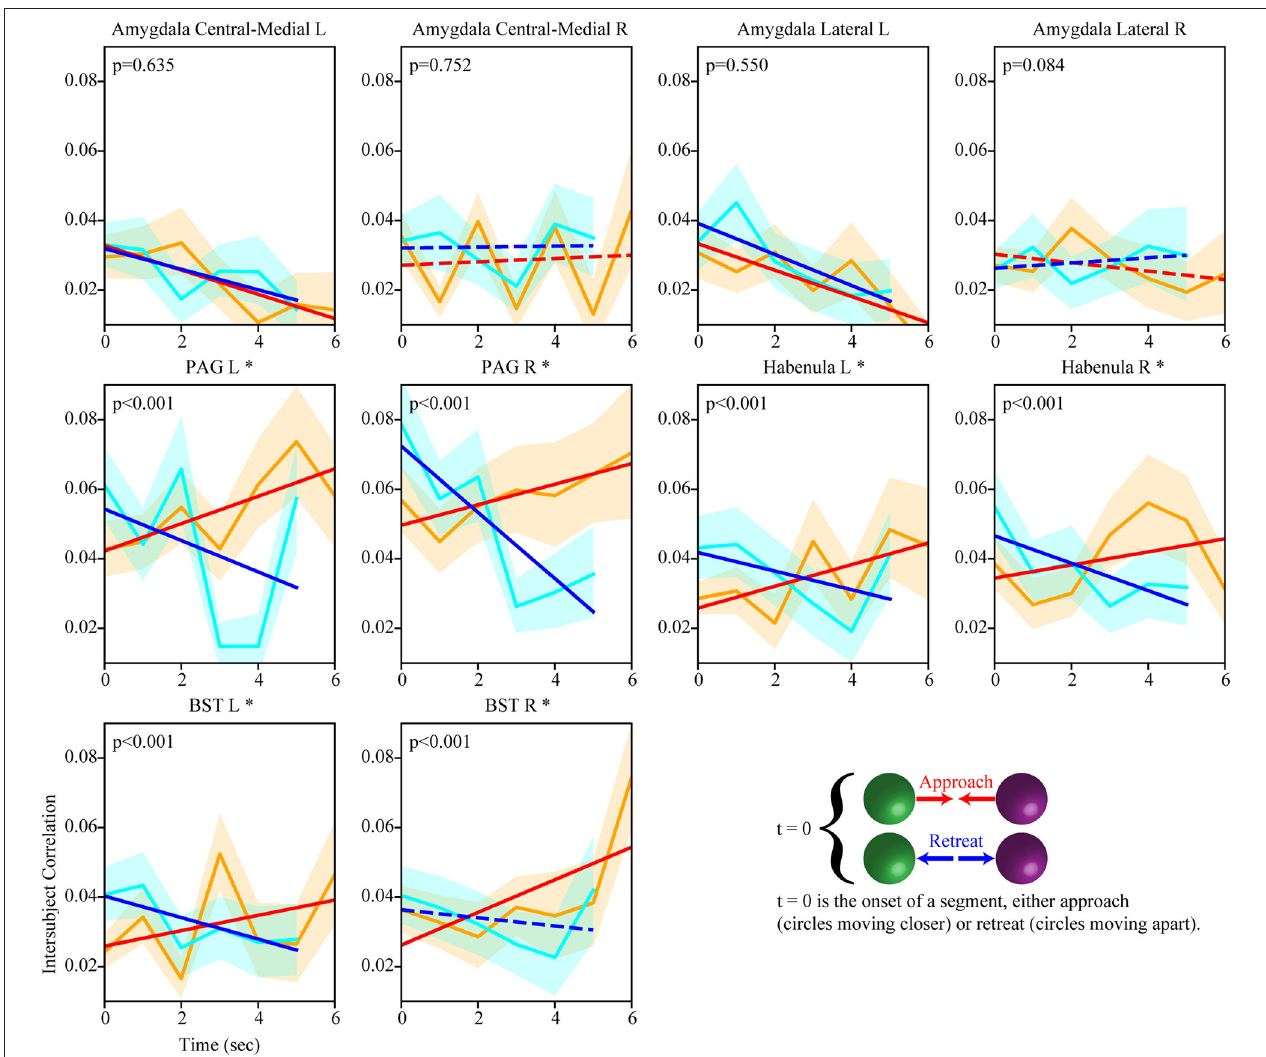
FIGURE 7 | Temporal evolution of intersubject weights between subcortical regions and the salience network (positive weights). Dynamic changes in intersubject correlation between subcortical regions and the salience network were detected for both approach and retreat. For example, for the right PAG, intersubject correlation increased during approach and decreased during retreat. Conventions as in Figure 5